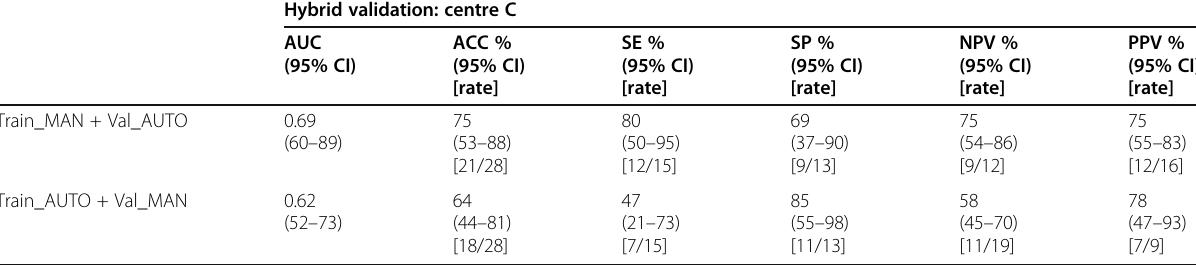
Table 5 Results on the hybrid validation for the two best models Hybrid validation: centre